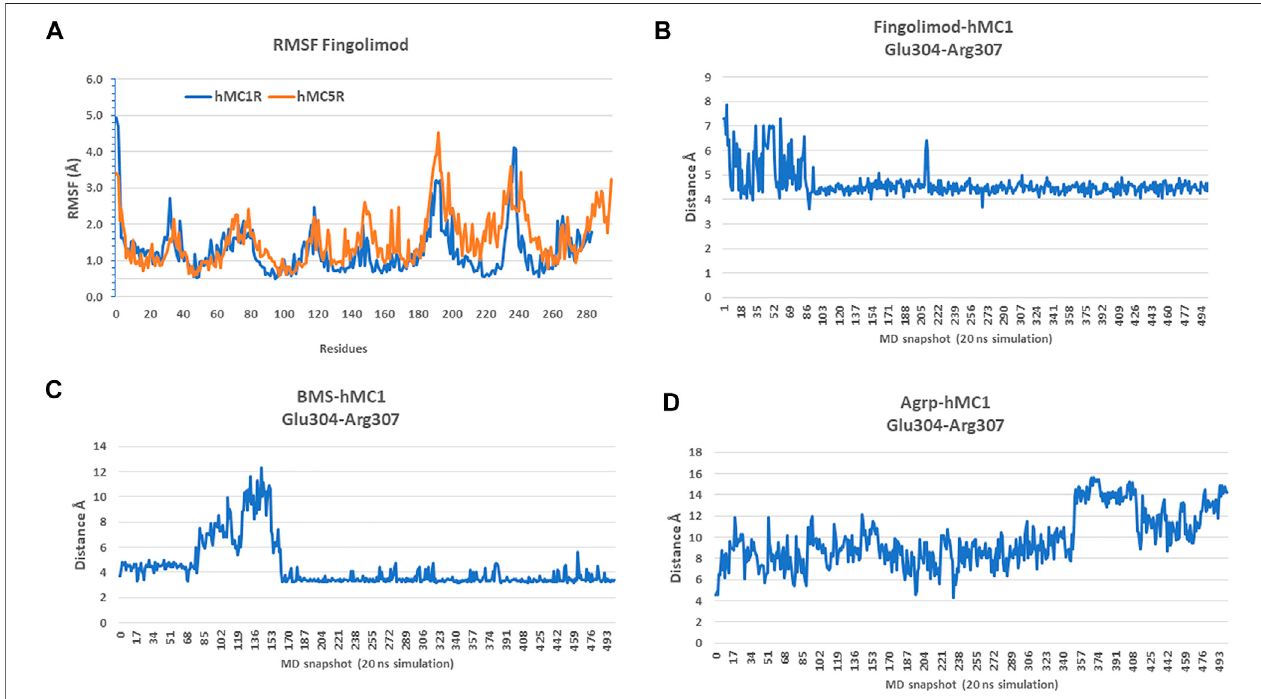
FIGURE 7 | Fingolimod stabilized hMC1R to lower root mean square fl uctuations (RMSF), compared to hMC5R. (A) RMSF of fi ngolimod-hMC1R (blue) complex and fi ngolimod-hMC5R(orange)complexasmeanof20nssimulations. (B) Glu304-Arg307salt-bridgedistanceduring20 nssimulationof fi ngolimod-hMC1Rcomplex. (C) Glu304-Arg307 salt bridge distance during 20 ns simulation of BMS-hMC1R complex. (D) Glu304-Arg307 salt bridge distance during 20 ns simulation of Agrp- hMC1R